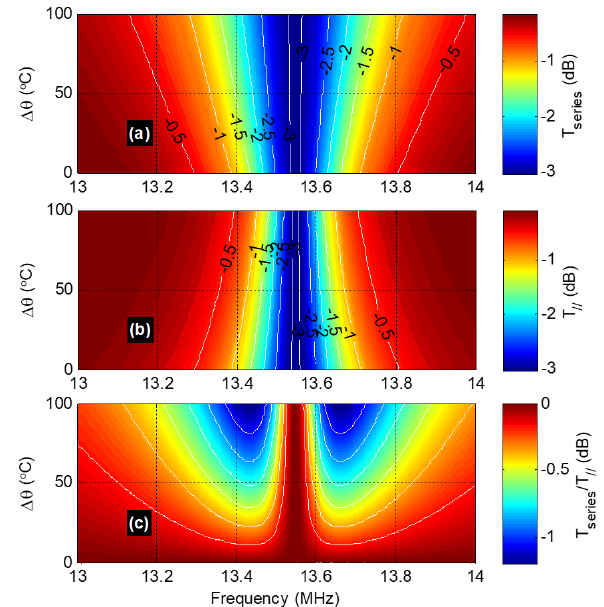
FIGURE 5. Thermo-frequency variable mappings of (a) RLC-series, (b) RLC- parallel VTF magnitudes and (c) ratio of both magnitudes from the circuits shown in Figs. 2.